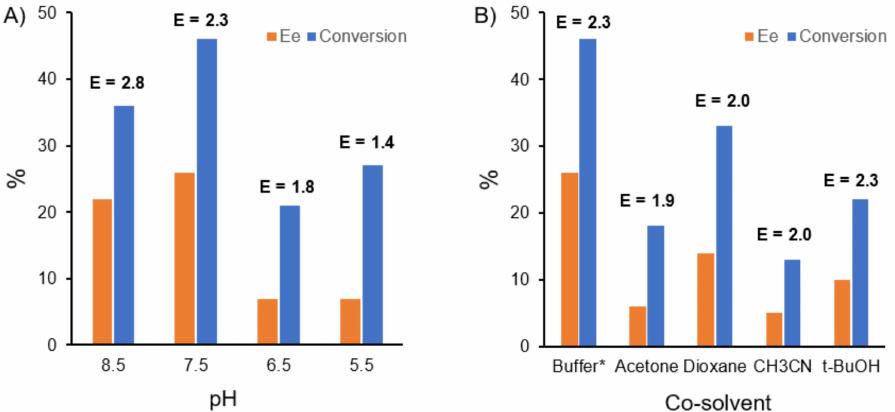
Figure 2. Influence of pH variation ( A ) and addition of co-solvents (20% v / v ) in the reaction medium ( B ) for the biocatalyzed kinetic resolution of methyl phenyl sulfoxide (1 h reaction time, 0.5 eqv. of oxidant, Buffer * = pH 7.5). E values calculated according to